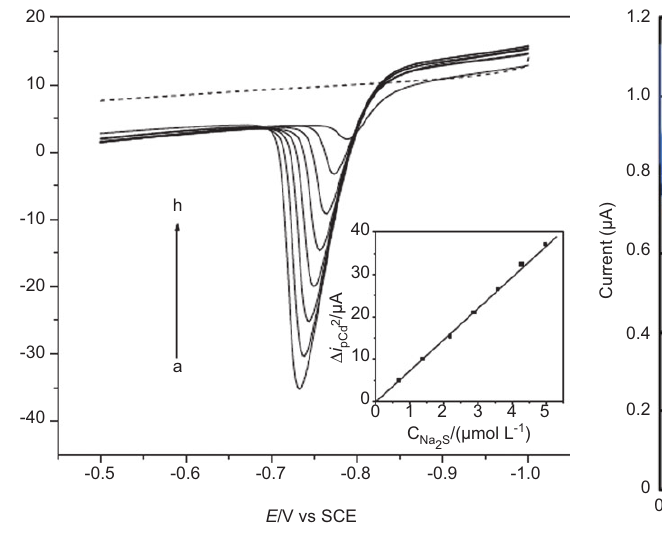
Figure 1 The anodic stripping voltammetry (ASV) response of Cd 2 + changed with the addition of sulfide. 0.1 m pH 4.5 NaAc-HAc(---base line) buffer solution at 3.6 × 10 -6 m ; A – H: 3.6, 4.3, 5.0 × 10 -6 m . Insert: plot of the relation between the peak current of Cd 2 + and the concentration of sulfide added.